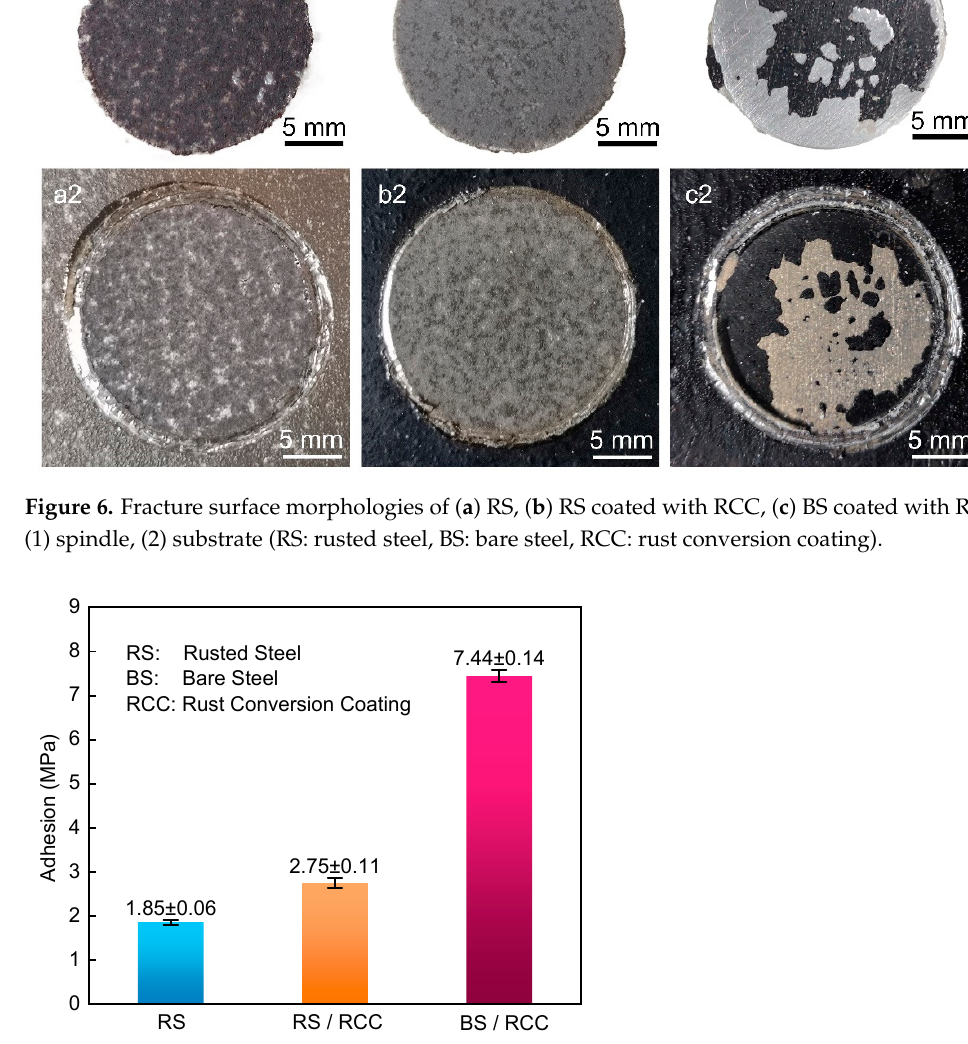
Figure 7. Adhesion strength of different samples corresponding to Figure 6.